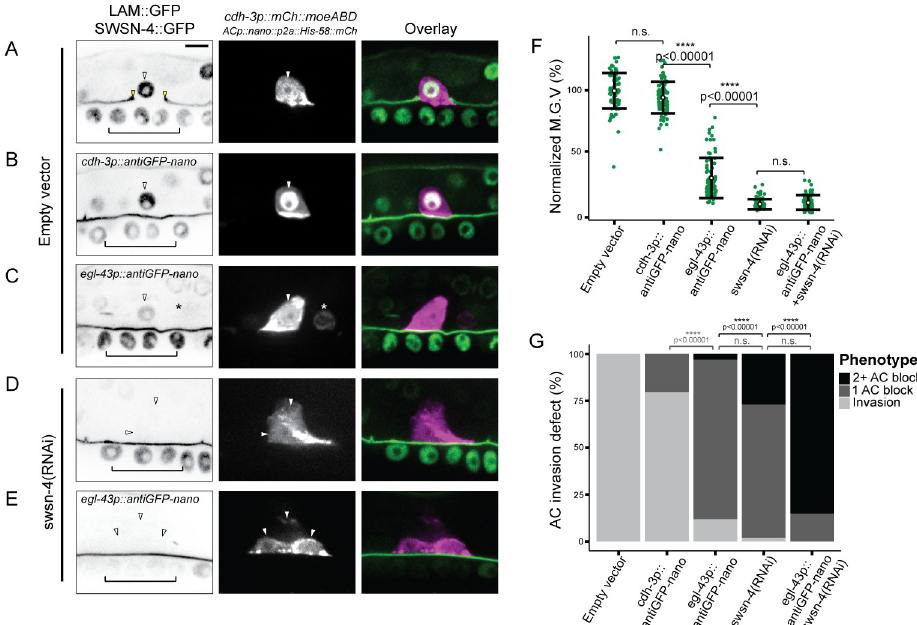
Fig 4. AC invasion and cell cycle arrest depend on dosage of SWI/SNF ATPase. (A-E) Representative fluorescence images depicting expression of BM marker ( laminin :: GFP ) and endogenous GFP::SWSN-4 (left), AC reporter ( cdh-3p :: mCherry :: moeABD , middle), and fluorescence overlay (right) across experimental treatments. White arrowheads indicate ACs, yellow arrowheads in A indicate boundaries of breach in BM. Black brackets indicate 1˚ VPCs. In cases where multiple cells expressed the AC reporter in the same animal, each is indicated with a single white arrowhead. Asterisk indicates anti-GFP nanobody expression in neighboring VU cell. (F) Quantification of mean gray values (M. G.V.) of endogenous GFP::SWSN-4 in ACs in control animals (empty vector) and across all experimental treatments normalized to mean fluorescent expression in wildtype animals (n � 40 animals per treatment, p values for Student’s t